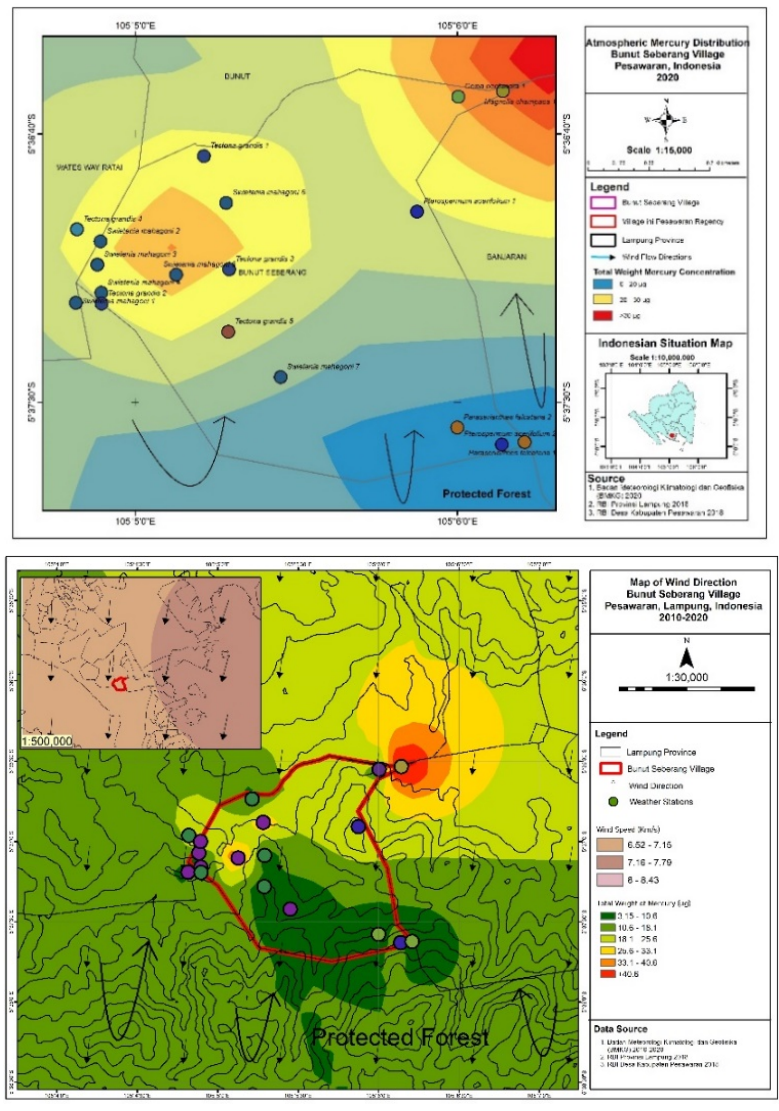
Figure 3. Atmospheric Hg distribution in the Bunut Seberang Village between 2010 and 2020.